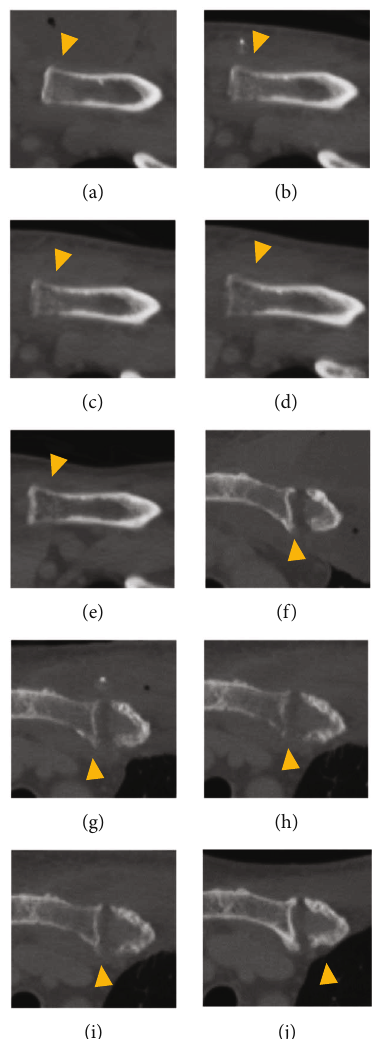
Figure 4: Chest computed tomography images with bone window: (a, f) on admission; (b, g) one week postoperatively; (c, h) two weeks postoperatively; (d, i) three weeks postoperatively; (e, j) four months postoperatively. Osteomyelitis (arrowhead) of the clavicle (a – e) and sternum (f – j) worsened within a few weeks after surgery but recovered within four months after